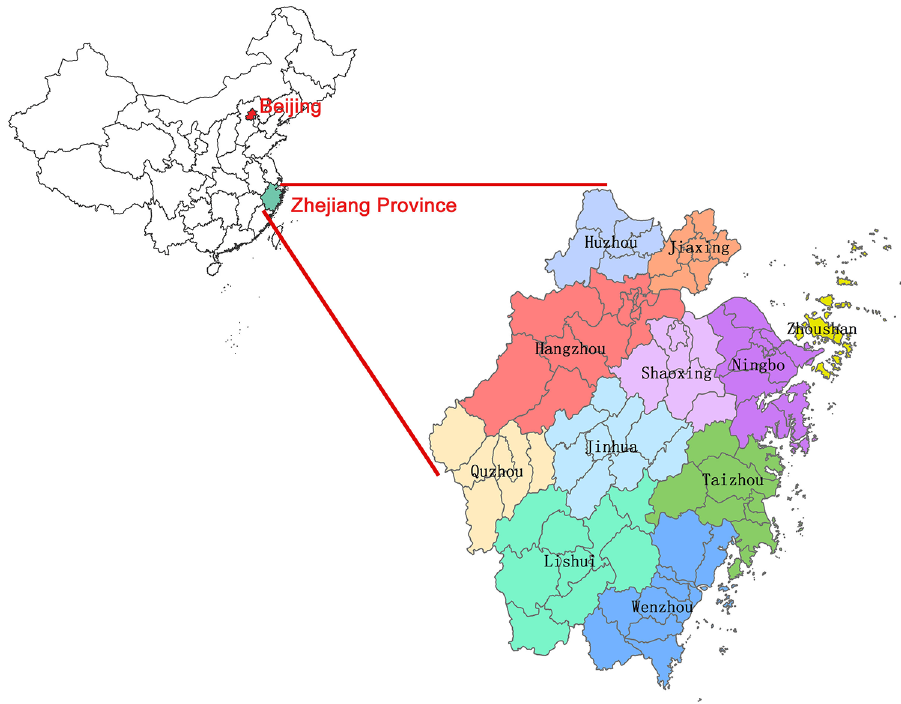
Fig 1. The map of Zhejiang